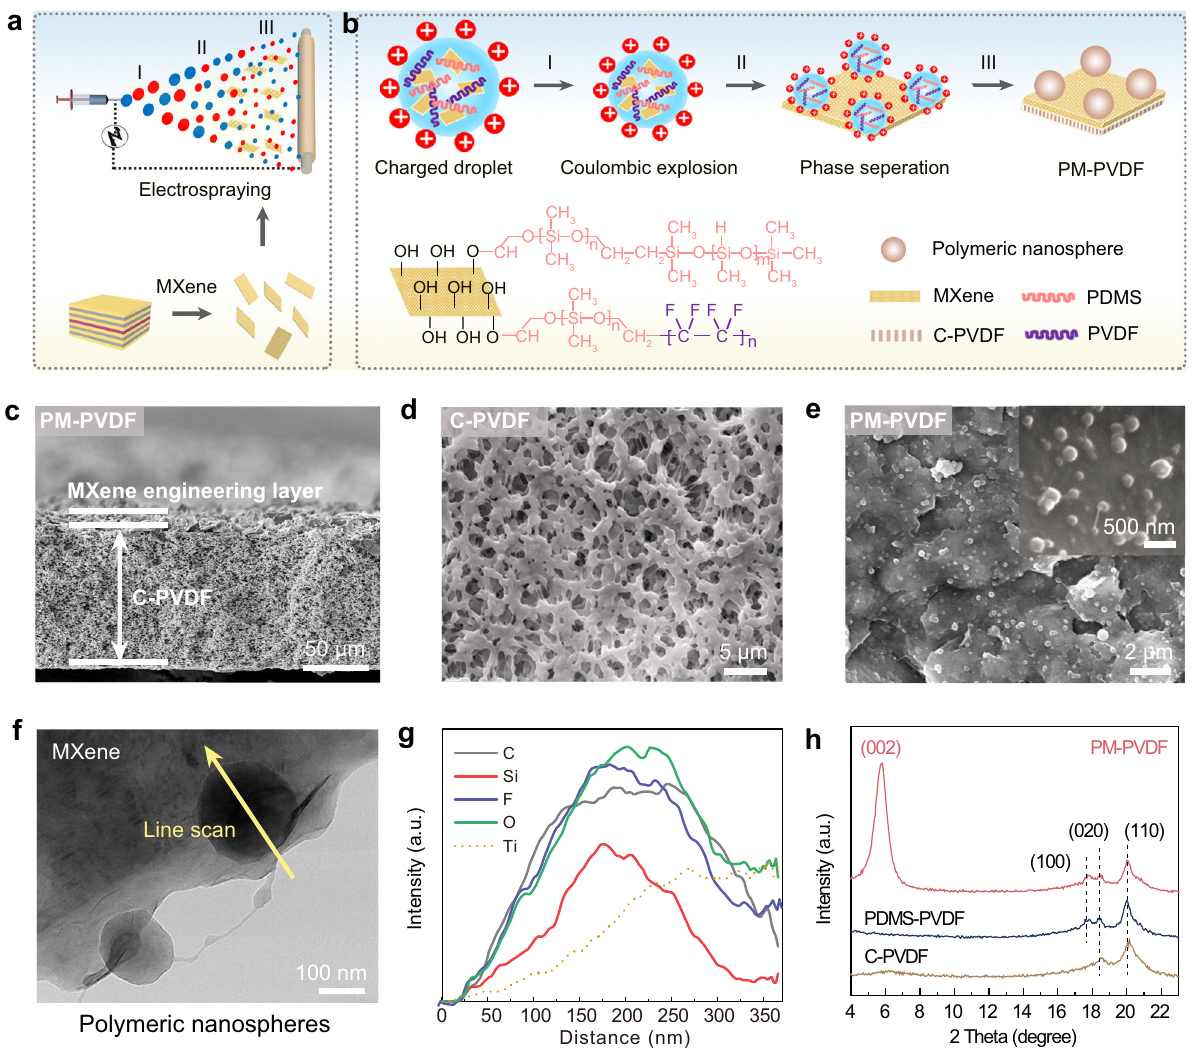
Fig. 2 Fabrication and structural characterization of membranes. a A schematic illustration of the interfacial engineering to fabricate the PM-PVDF membrane. MXene was synthesized by etching-exfoliation method and then engineered onto C-PVDF membrane by a facile electrospraying process. b Electrically conductive MXene-directed self-assembly of polymeric nanospheres by electrospraying. The formation of polymeric nanospheres involves three steps including the formation of charged droplets, coulombic explosion, and phase separation. The high electrical conductivity and suf fi cient surface functional groups of MXene play a structure-directing for the assembly of polymeric nanospheres, which can only be generated when PDMS and highly molecular PVDF are both present. c Cross-sectional SEM image of the PM-PVDF. d SEM image of the C-PVDF and ( e ) PM-PVDF. f TEM image of 2D MXene nanosheets decorated with polymeric nanospheres. g Corresponding EDS line scan on the polymeric nanospheres with spherical elements distribution. h GIXRD patterns. Source data are provided as a Source Data fi